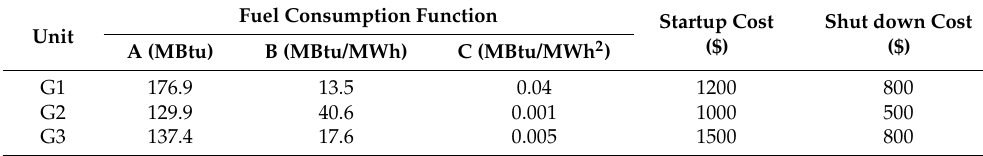
Table 3. Generator energy data.